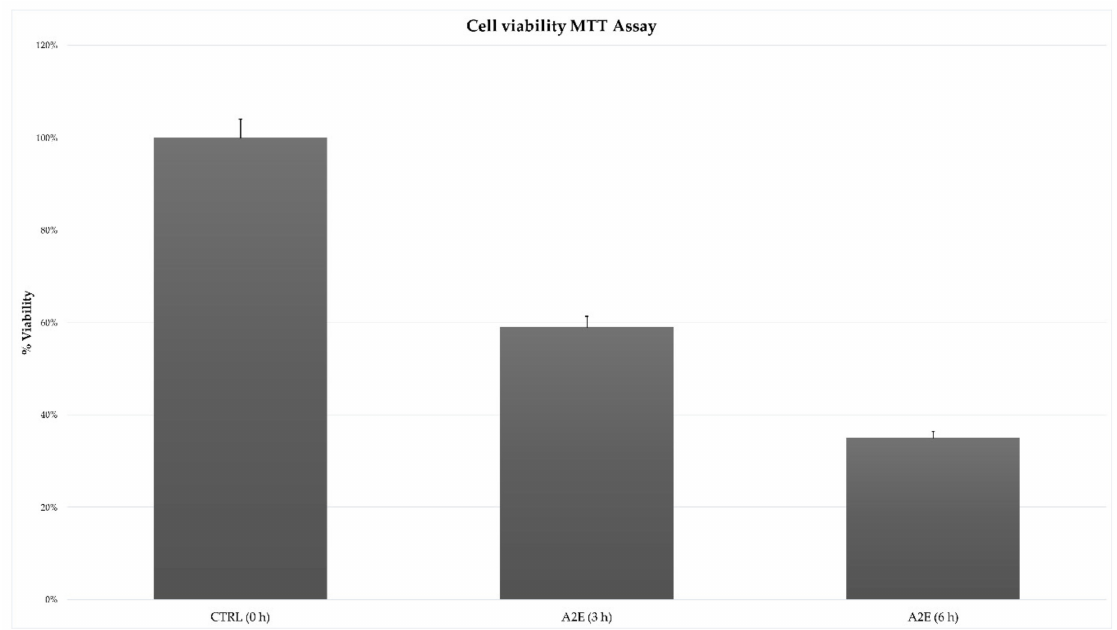
Figure 1. E ff ect of N-retinylidene-N-retinylethanolamine (A2E) on retinal pigment epithelium (RPE) cells toxicity. Results of MTT assay showed a time-dependent cytotoxicity induced by A2E treatment. Cell viability percentage is expressed as mean ± SD ( n = 3). Multiple t -tests were performed for statistical comparisons ( p -values <